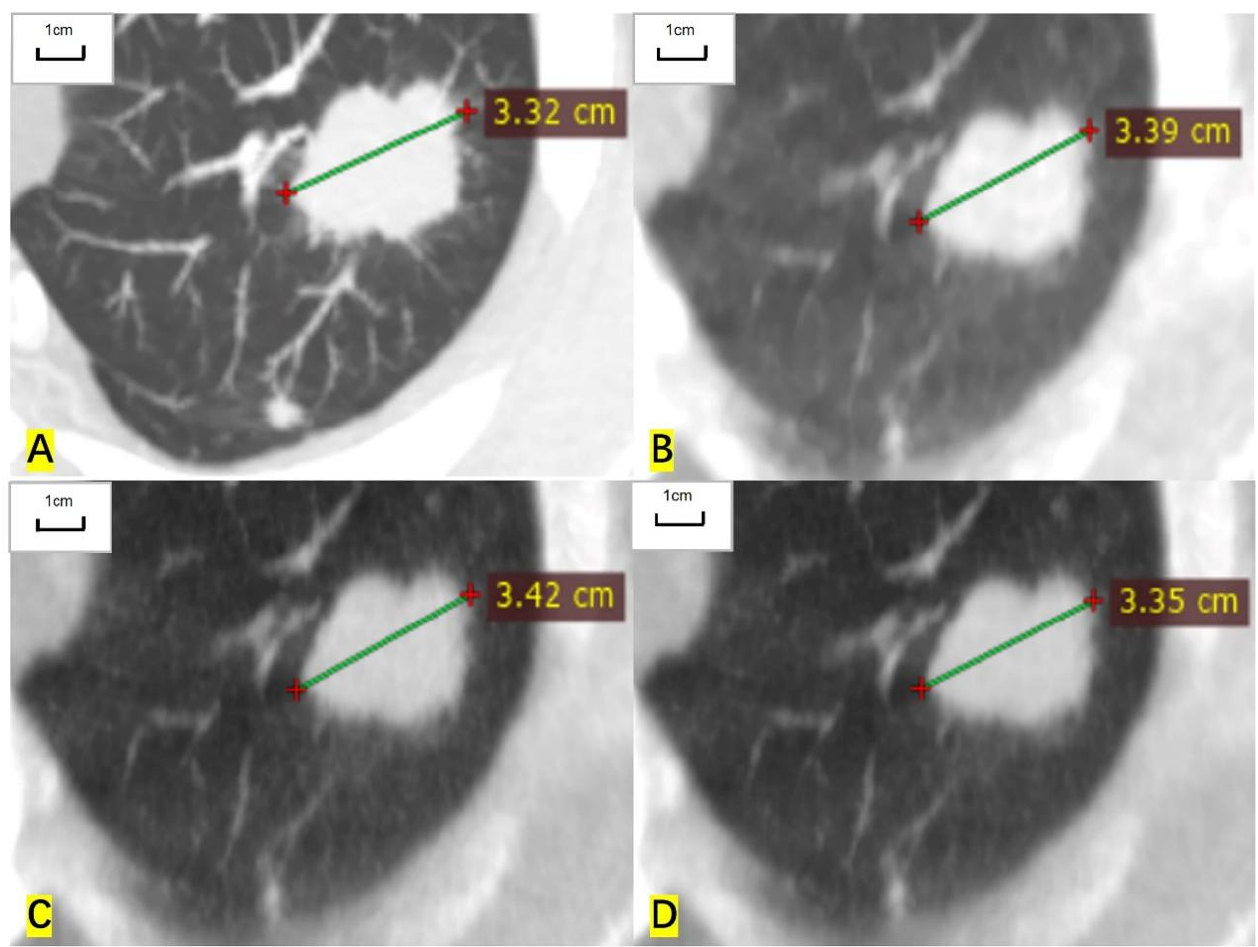
Figure 1. A 57-year-old man had a measurable target lesion in the upper lobe of the left lung and the histological result was lung adenocarcinoma. ( A ) The long diameter measured on the contrast- enhanced CT image is 33.2 mm. ( B ) The measured long diameter on the ASIR-V-80% reconstructed image is 33.9 mm. ( C ) The measured long diameter on the DLIR-M image is 34.2 mm. ( D ) The measured long diameter on the DLIR-H images is 33.5 mm. The long diameter is overestimated by 2.1%, 3.0%, and 0.9%, respectively, compared with that of contrast-enhanced CT. There were 64 small lymph nodes (5 mm ≤ short diameter < 10 mm) in the 141 patients, including 4 malignant and 60 benign or without histological results.